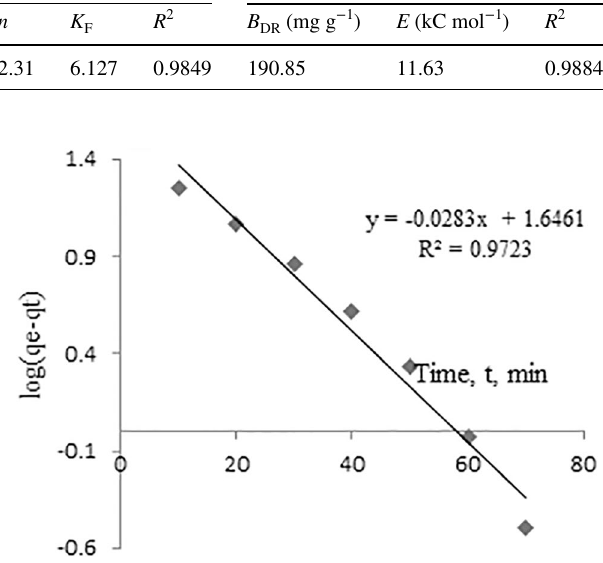
Fig. 6 Plots of pseudo-first order model